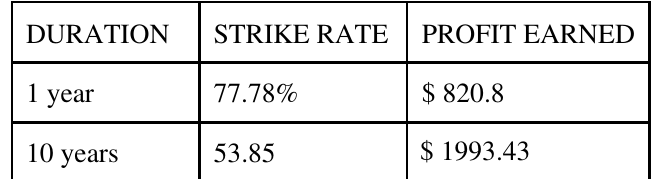
Table 3: Moving Average Evaluation